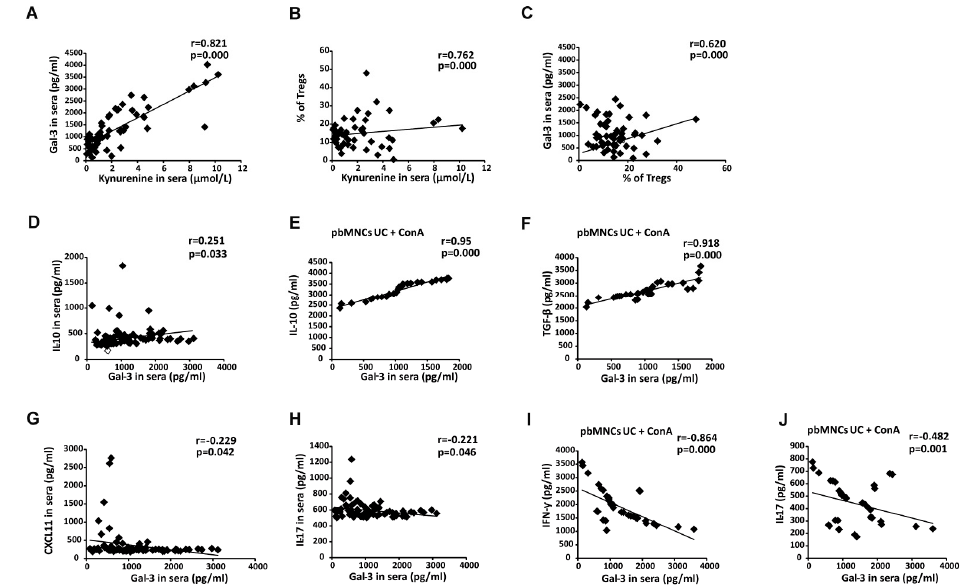
Figure 8. Increased serum levels of Gal-3 indicates overproduction of immunosuppressive cytokines in UC patients. Correlation between serum concentrations of Gal-3 and KYN ( A ), KYN and percentage of colon-infiltrated Tregs ( B ), serum levels of Gal-3 and percentage of colon-infiltrated Tregs ( C ), serum concentration of Gal-3 and IL-10 ( D ). Correlation between serum level of Gal-3 and concentration of IL-10 ( E ) and TGF- β ( F ) in supernatants of Con A-stimulated pbMNCs. Correlation between serum levels of Gal-3 and CXCL11 ( G ) and between serum concentration of Gal-3 and IL-17 ( H ). Correlation between serum level of Gal-3 and concentration of IFN- γ ( I ) and IL-17 ( J ) in supernatants of Con A-stimulated pbMNCs.